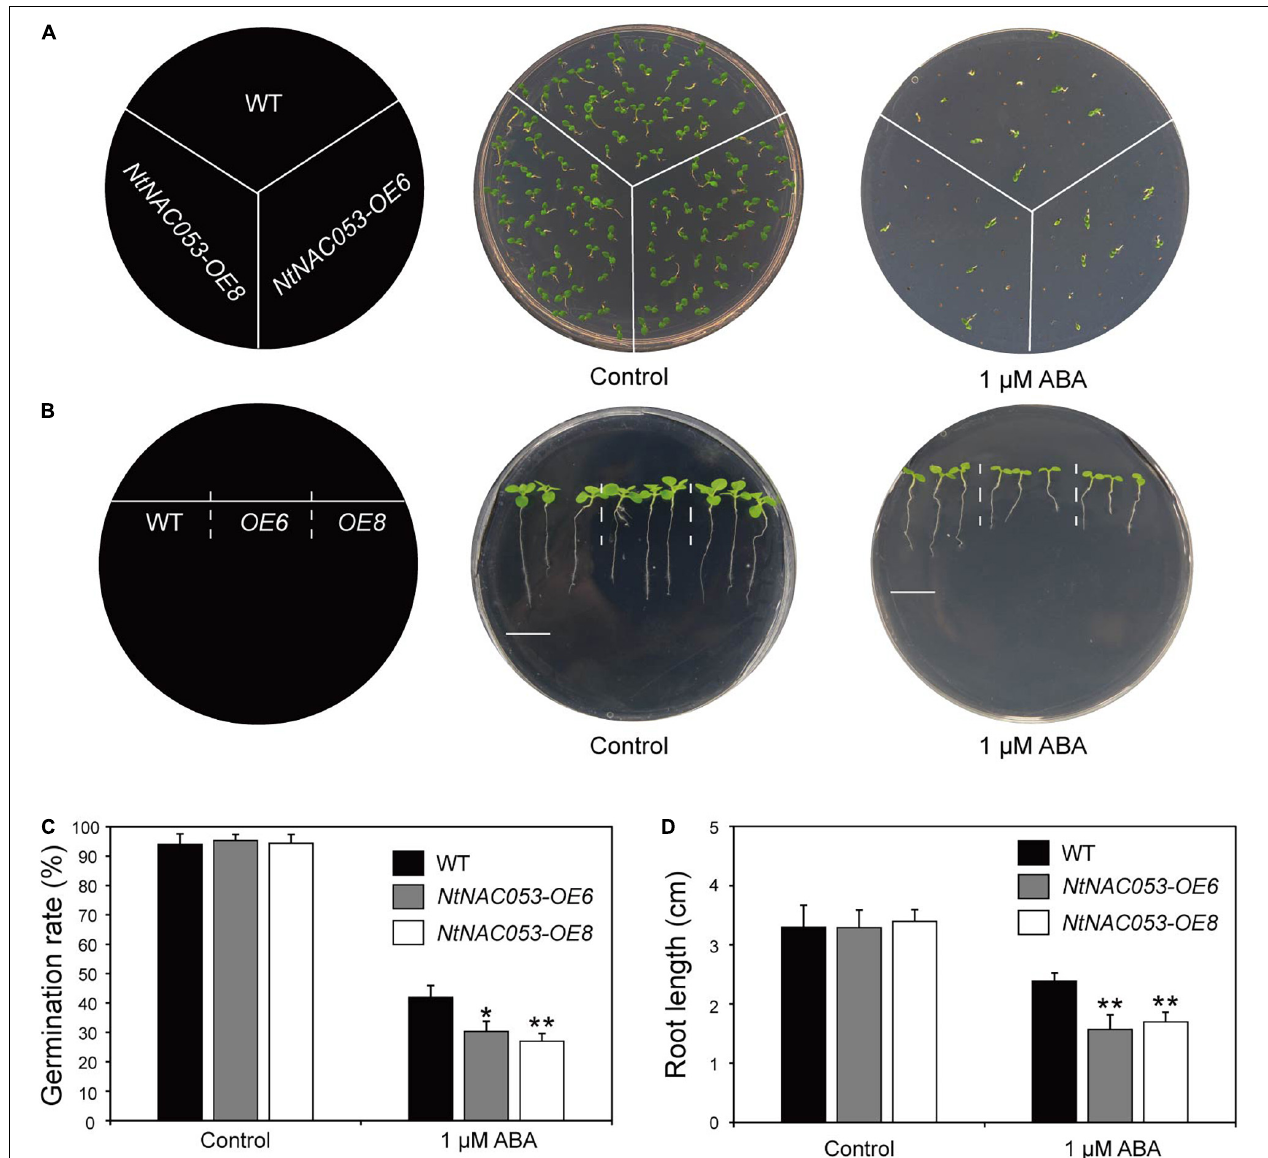
FIGURE 4 | Overexpression of the NtNAC053 gene confers ABA hypersensitivity. (A) Seed germination assay between overexpression lines and wild type under 1 µ M ABA treatment. (B) Root elongation assay between overexpression lines and wild type under 1 µ M ABA treatment. Bar = 1.5 cm. (C) The statistics of germination rates under normal conditions and 1 µ M ABA treatment. (D) The statistics of primary root length under normal conditions and 1 µ M ABA treatment. WT, wild type. The data were means ± SD from three independent replications. * p < 0.05, ** p < 0.01 ( t